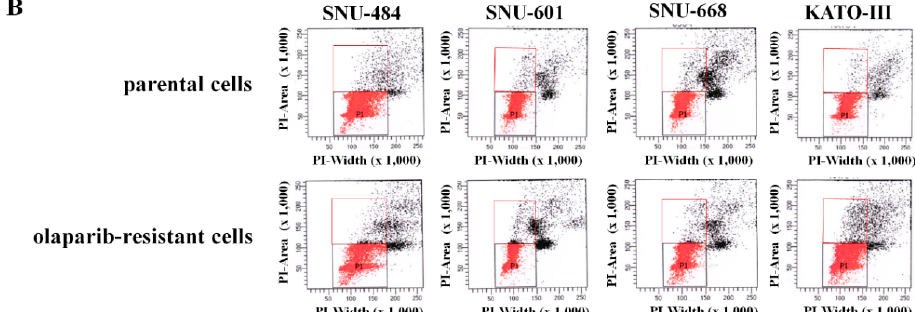
Figure 3. The nuclei were larger in olaparib-resistant cells than in parental cells. The degree of DNA